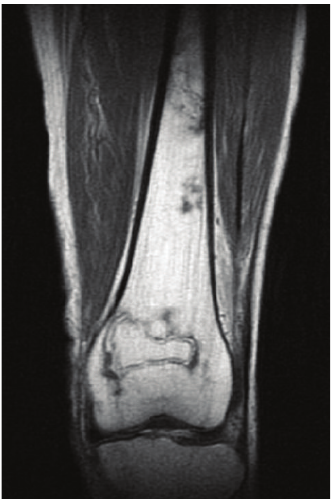
Figure 4: T1W coronal section MRI showing multiple demarcated bone marrow abnormalities with double-line sign, compatible with